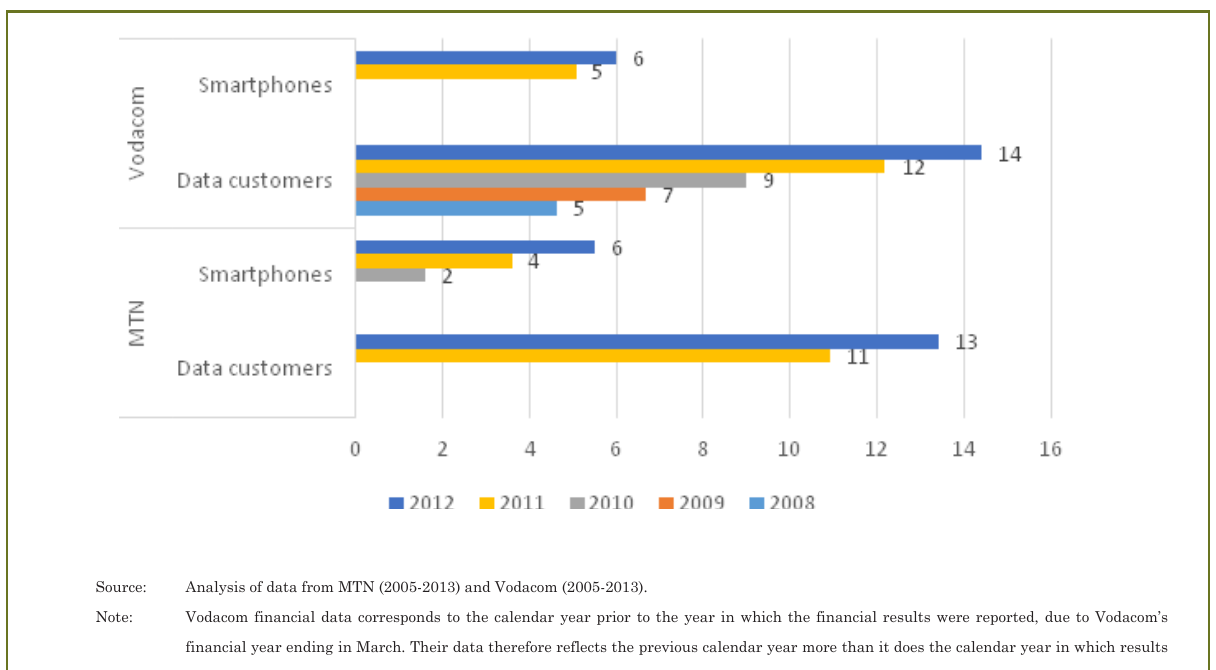
FIGURE 7: DATA CUSTOMERS, 3G DEVICES AND SMARTPHONE PENETRATION